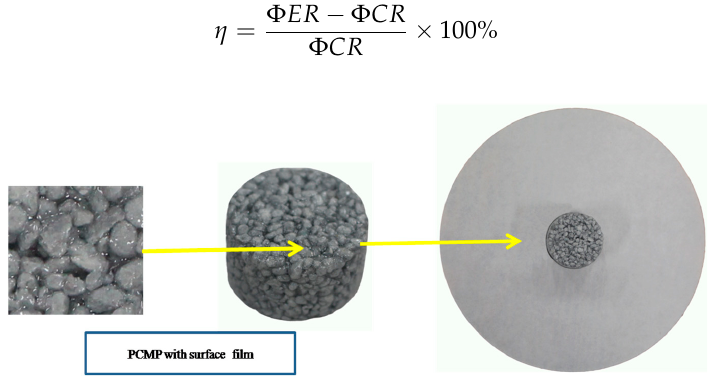
Figure 4. Schematic diagram of diffusion–effusion circle test.